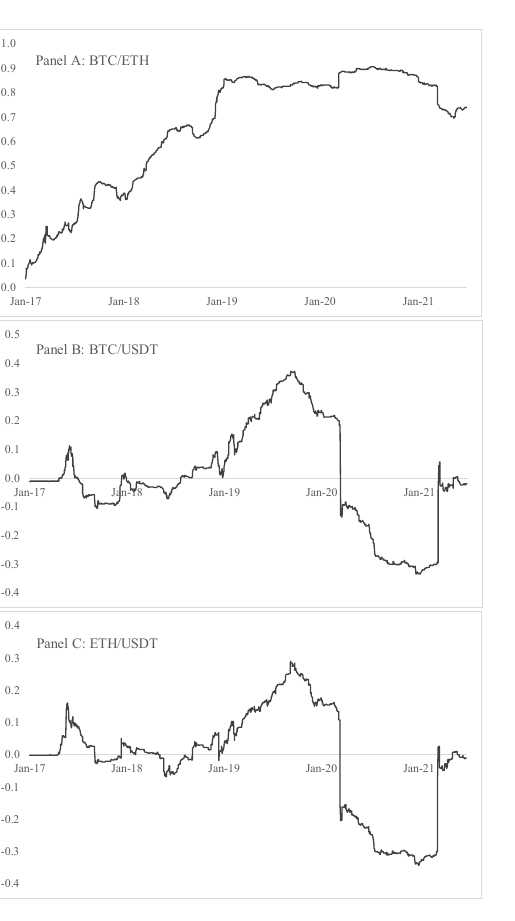
Figure 2. Rolling unconditional correlation (1 year).